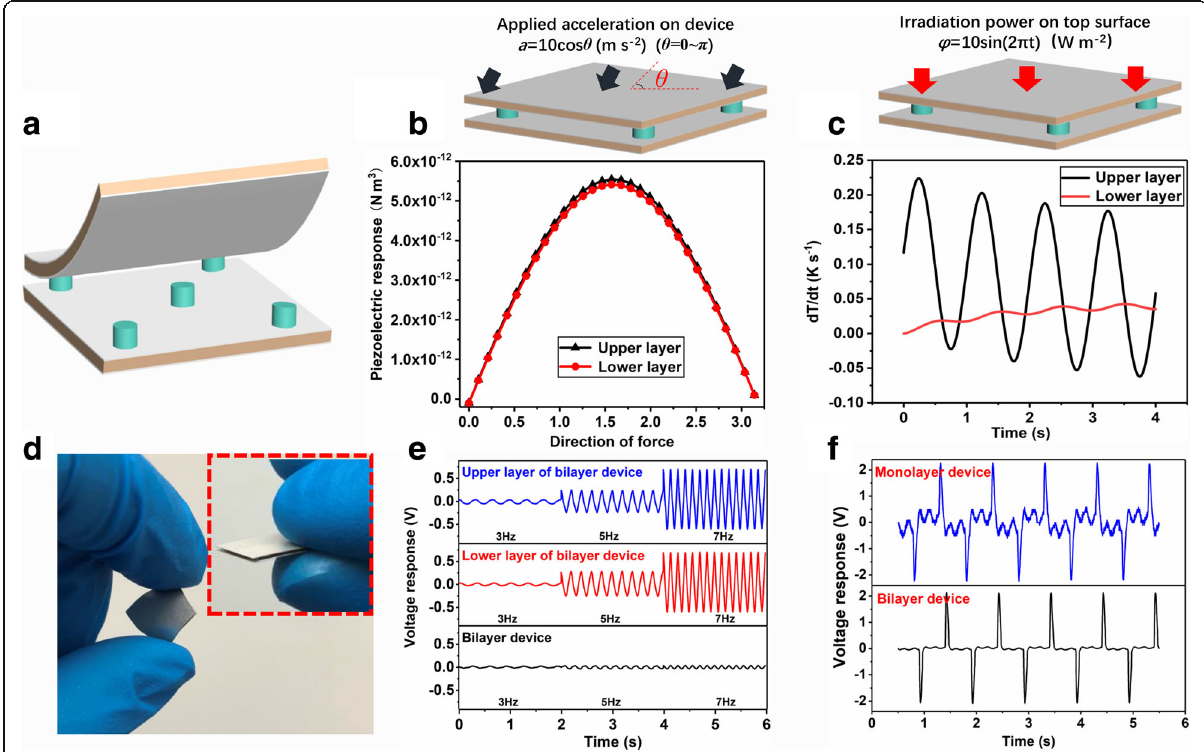
Fig. 4 Simulation and measurement results of the bilayer-structured pyroelectric sensor. a Explored schematic of the device structure. b Model and results of piezoelectric response simulation. c Model and results of thermal simulation. d Optical photo of the fabricated device. e Piezoelectric response at different frequencies. f Responses of the bilayer and conventional monolayer devices when simultaneously stimulated by mechanical vibration (5Hz) and thermal irradiation